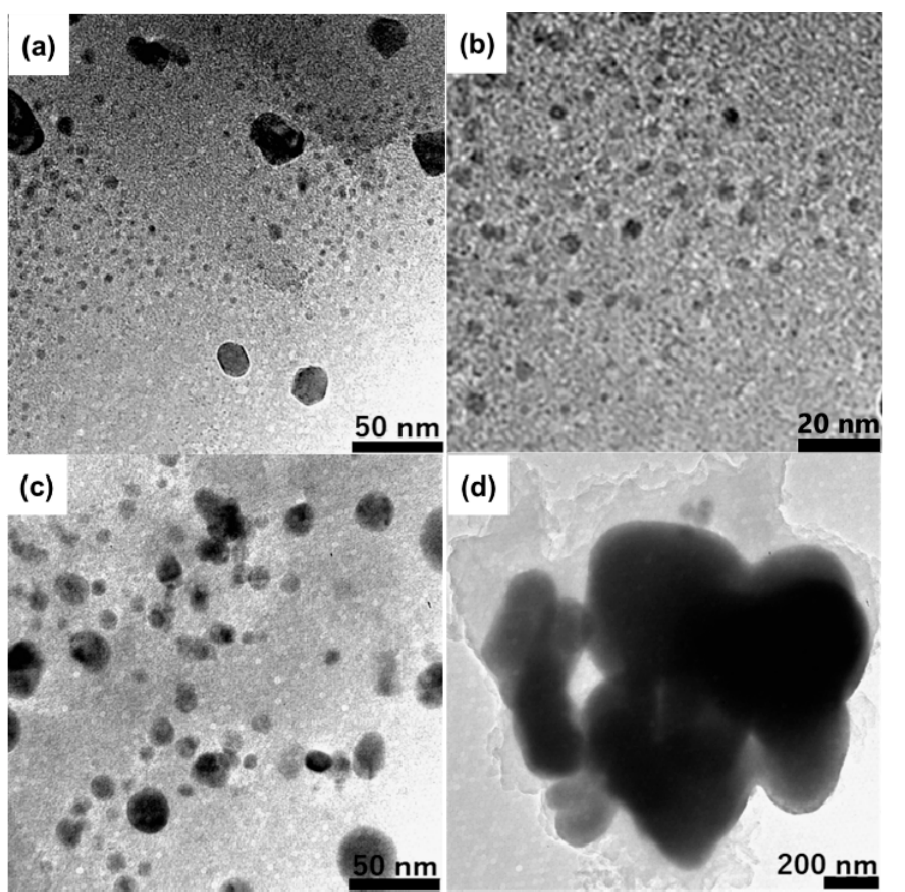
Figure 3. TEM images of ( a ) Cu@C synthesized at 5 GPa/500 °C, ( b ) magnified view of ( a ), ( c ) Cu@C synthesized at 5 GPa/400 °C, and ( d ) Cu@C synthesized in a vacuum-sealed glass tube (vacuum/400 °C).